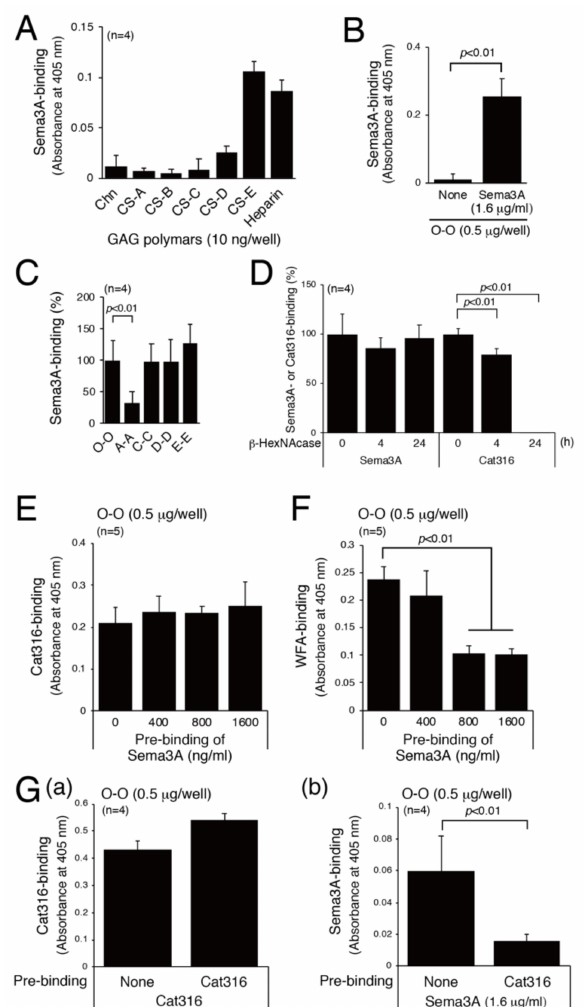
Figure 3. The Sema3A binding motif is partially recognized by Cat316 and WFA. ( A ) Binding of Sema3A to biotinylated Chn and GAG polymers (CS-A, CS-B, CS-C, CS-D, and heparin) was examined by ELISA. ( B ) Binding of Sema3A to biotinylated tetrasaccharides, O-O, was examined by ELISA. ( C ) Binding of Sema3A to A-A, C-C, D-D, and E-E tetrasaccharides is shown as a percentage of the binding of Sema3A to O-O tetrasaccharides. ( D ) Binding of Sema3A and Cat316 to O-O tetrasaccharides